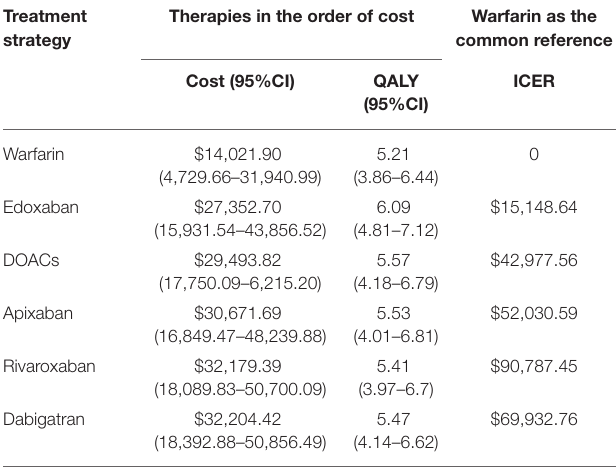
TABLE 5 | Estimated costs, QALYs and ICER in PSA analyses on a 10-year time horizon. Treatment strategy